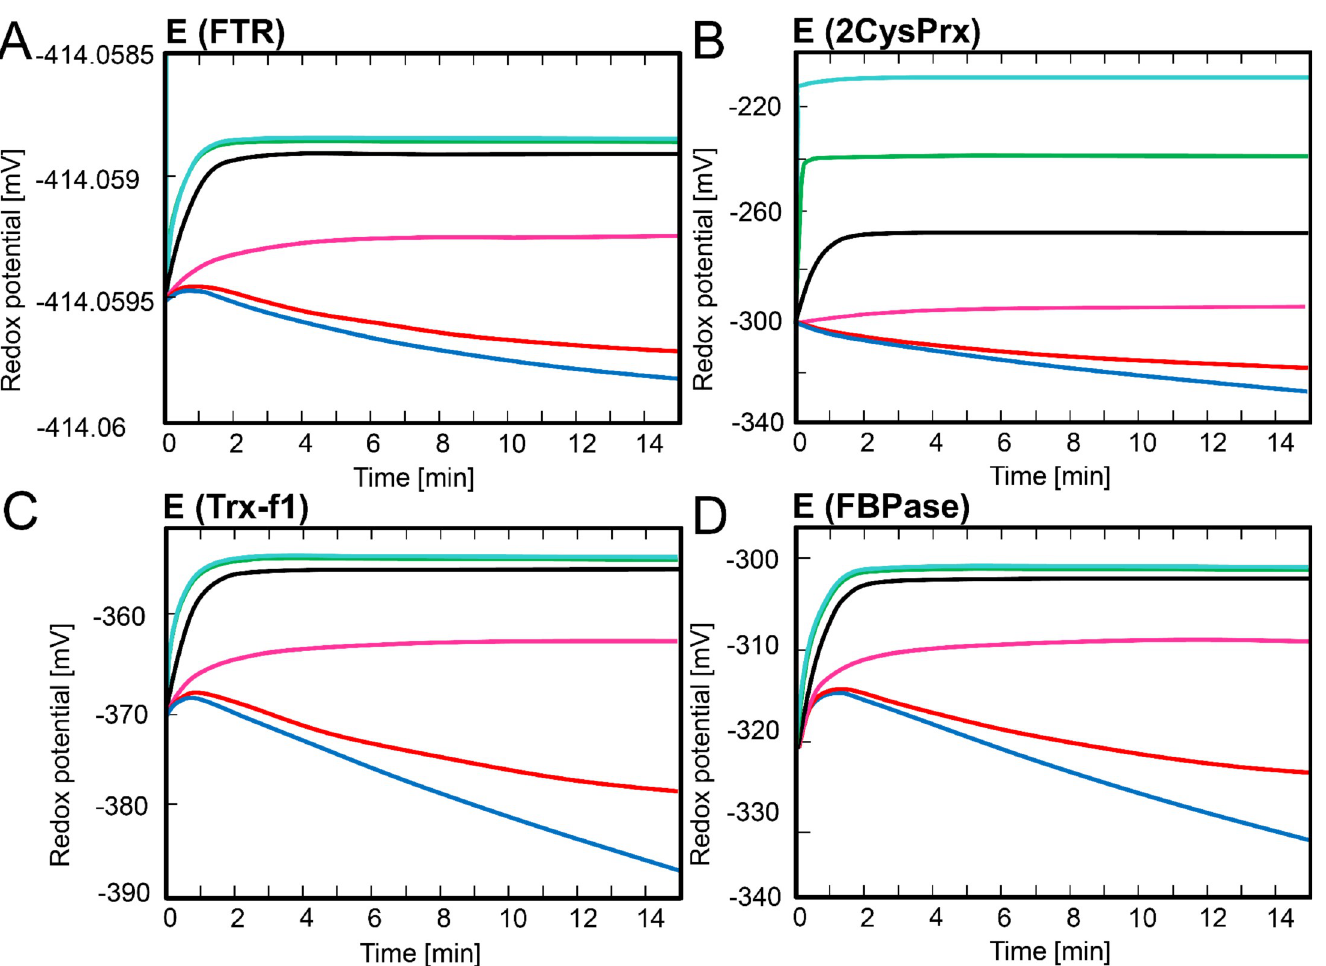
Fig 2. Time-dependent simulation of redox potential changes of FTR-network components. The redox potentials of FTR, TRX-f1, FBPase, 2CysPRX were simulated at varying H 2 O 2 concentrations. Redox potentials were calculated at each time step using the Nernst equation for (A) FTR, (B) 2CysPRX, (C) TRX-f1 and (D) FBPase. The simulation was run for 15 min for each H 2 O 2 concentration adjusted to 0 nM (blue), 1 nM (red), 10 nM (magenta), 100 nM (black), 1 μ M (green) and 10 μ M